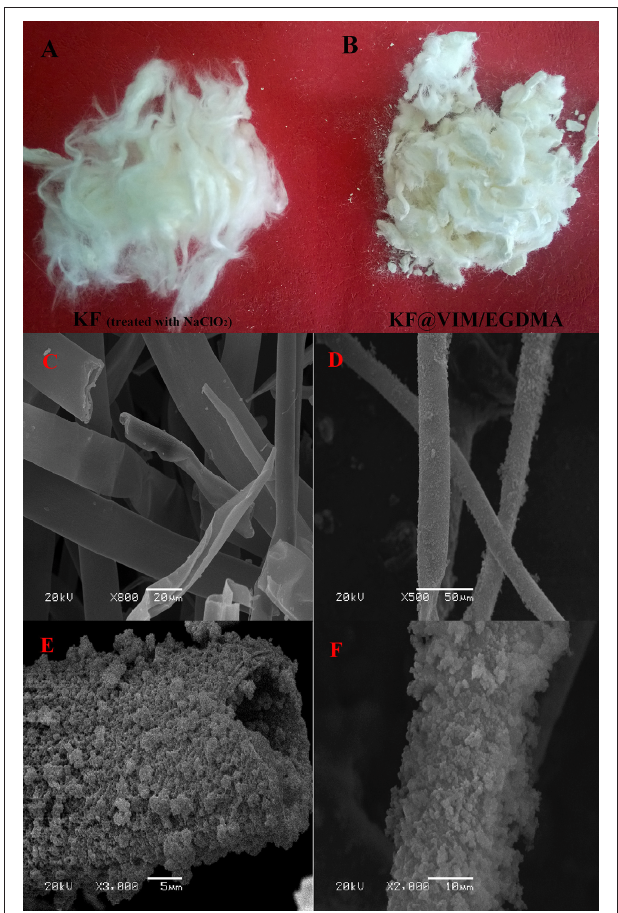
FIGURE 2 | Photographs of the treated KF (A) and KF@VIM/EGDMA (B) and SEM image of the KF (C) and KF@VIM/EGDMA (D–F).